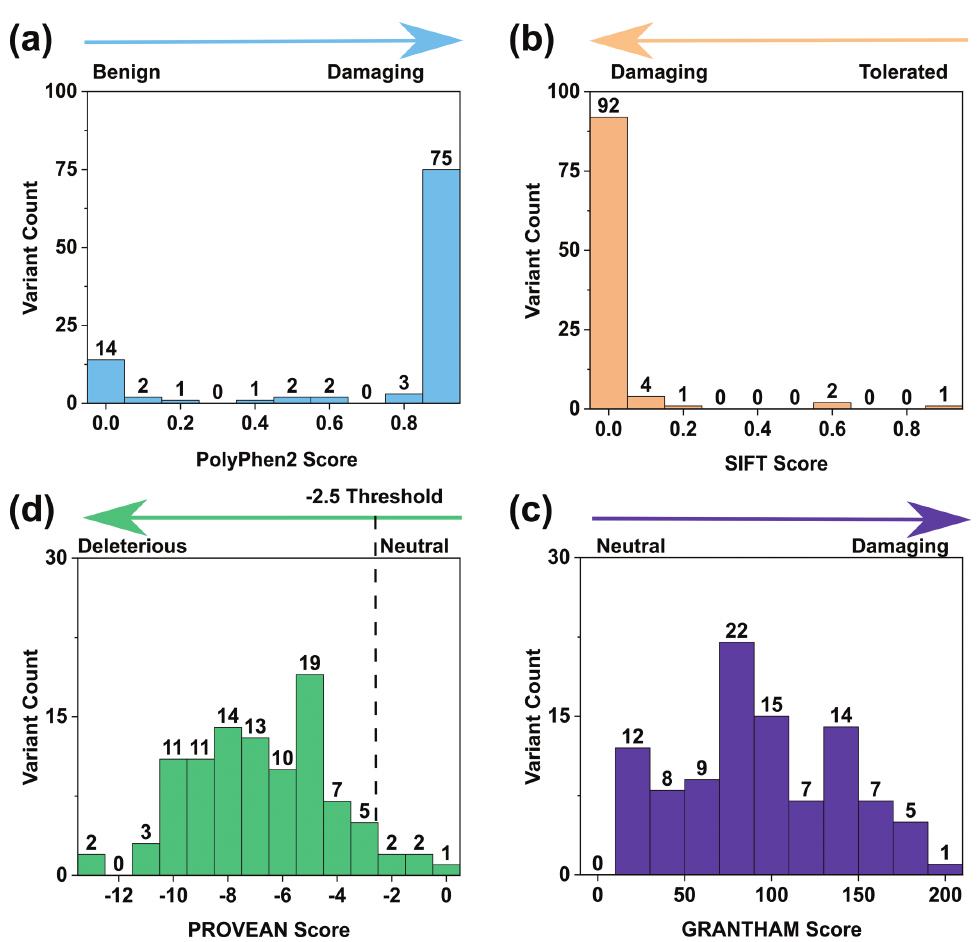
Fig. 6 Substitution analysis of 100 FV de fi ciency missense variants in the F5 gene. The four substitution analyses predict the damaging effects of substitution variants on the protein structures. ( a ) Analysis of the variants determined by their PolyPhen-2 scores. ( b ) Analysis of variants determined by their SIFT scores. ( c ) Analysis of variants determined by their PROVEAN scores. The PROVEAN threshold used was (cid:2) 2.5. ( d ) Analysis of the variants determined by their Grantham scores. FV, Factor